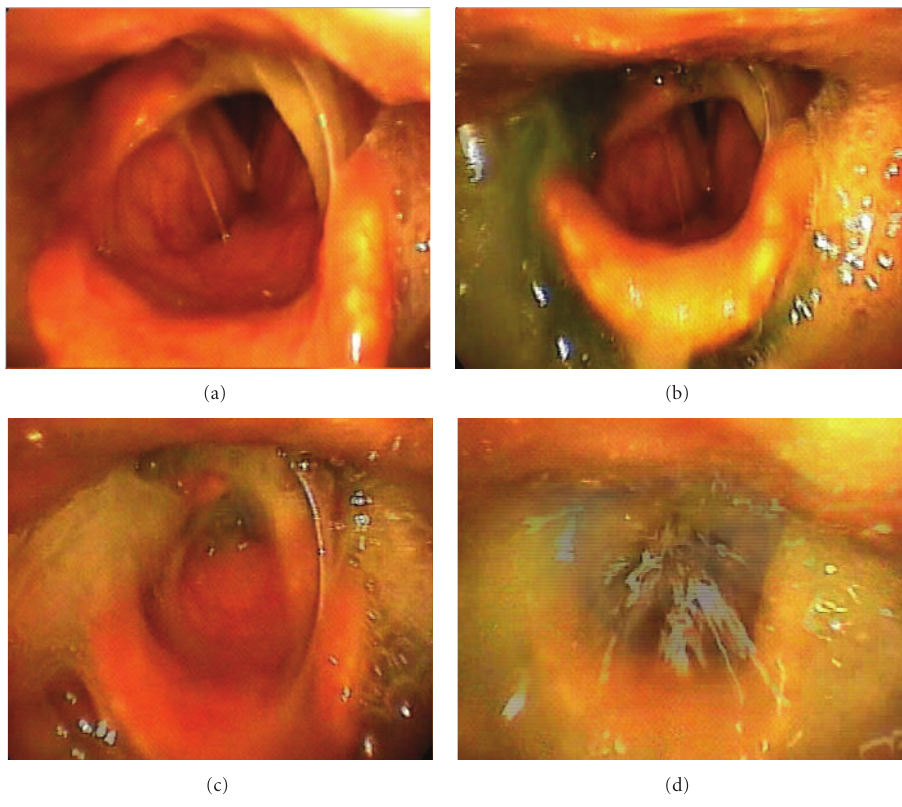
Figure 4: Fiberoptic endoscopic evaluation of swallowing. (a) Anatomy and function can be evaluated at the beginning of the examination. Endogenous secretions retention and even penetration or aspiration at rest suggest sensory impairment. (b) The swallow trial always starts with honey consistency, the easier to manage. Dysfunction is further corroborated as there is immediate penetration. (c) The patient shows evident aspiration. (d) The larynx is extraordinarily dysfunctional from the safety point of view. Obviously the patient has to refrain from oral